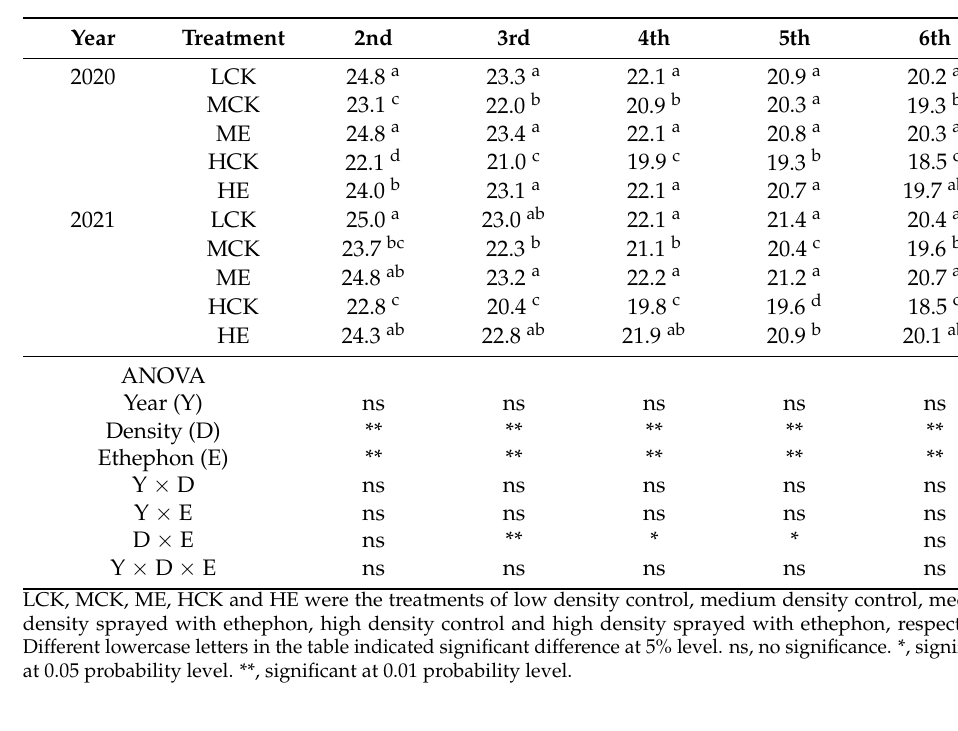
Table 3. Effects of spraying ethephon on stem diameter (mm) of summer maize.